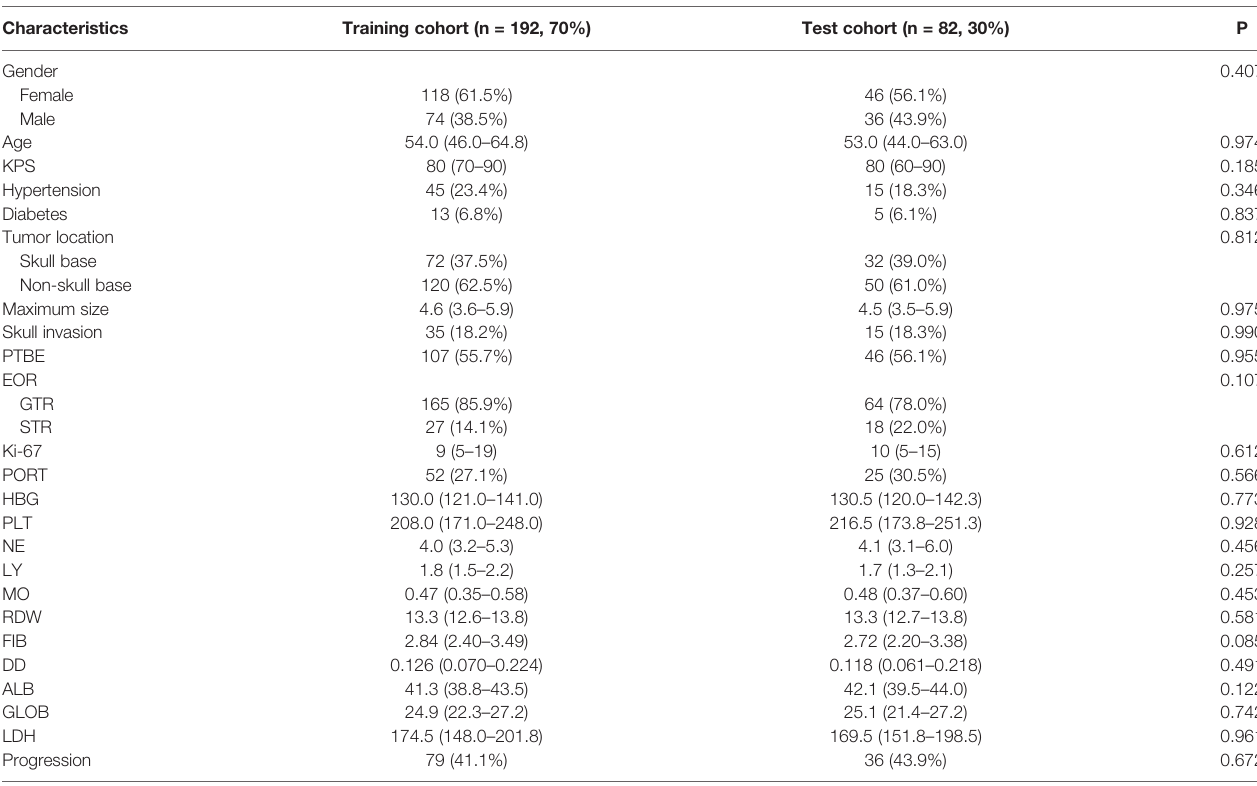
TABLE 1 | Clinical characteristics of the training cohort and test cohort.